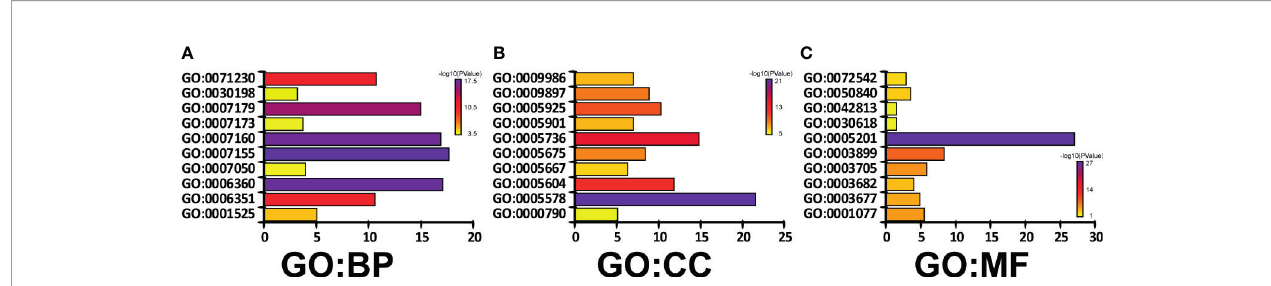
FIGURE 5 | Genes signi fi cantly associated with CAVs and CAVINs alterations indicated by GO enrichment as (A) biological processes, (B) cellular components, and (C) molecular